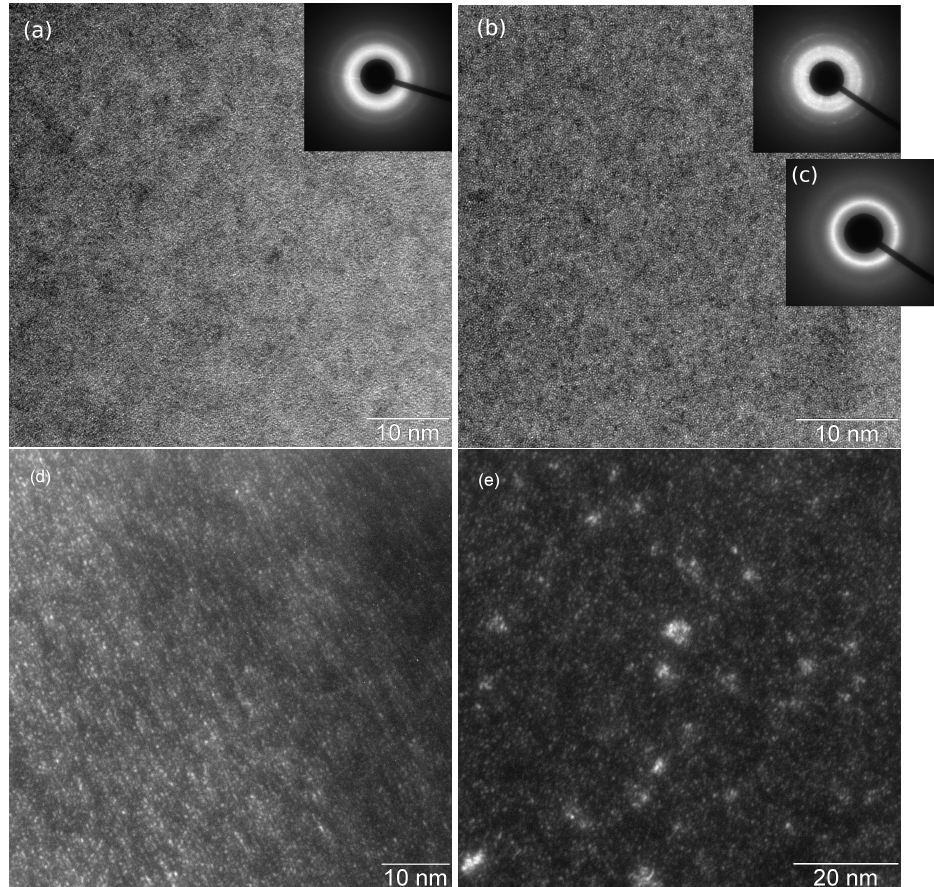
Figure 1. Microstructure of the Vit105 BMG: ( a ) as-cast (HRTEM, SAED); ( b ) subjected to HPT for n = 30 (HRTEM, SAED); ( c ) subjected to HPT for n = 30, SAED in an area without strain-induced nanocrystallization; ( d ) as-cast, TEM, dark field, ( e ) HPT n = 30, TEM, dark